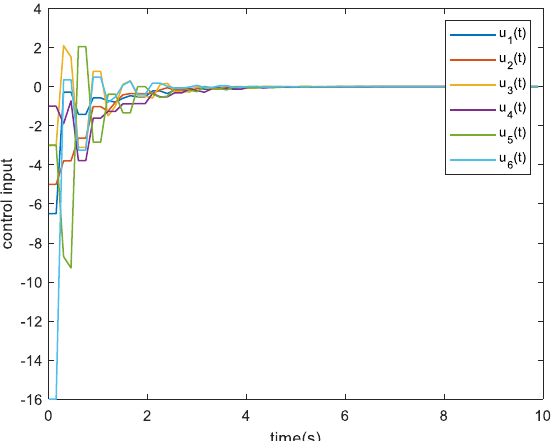
Figure 7. Control inputs for the agents.